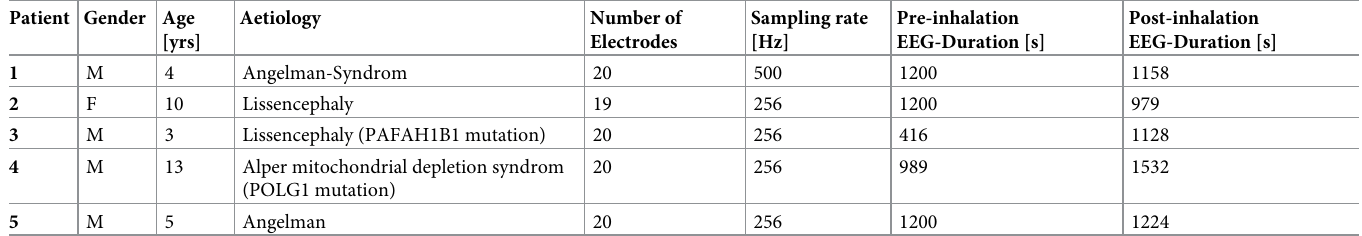
Table 1. Clinical and demographic information of all